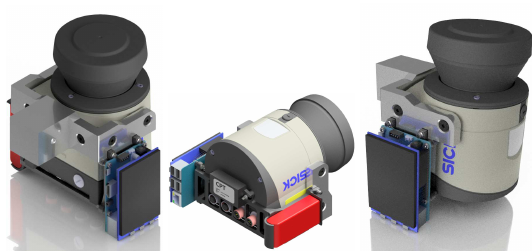
Figure 1. CAD model of assembled measuring unit combining: SICK LMS141 2D laser scanner, a single board computer and the necessary electrical components.